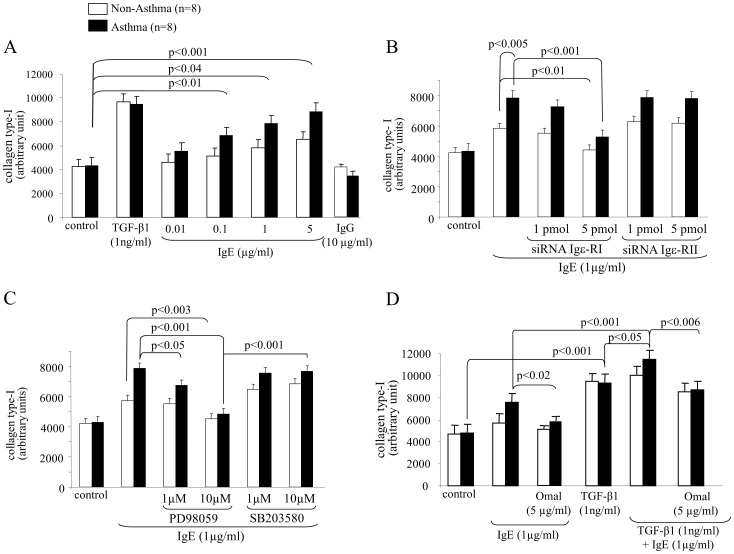
IgE induces collagen type-I deposition by ASMC through Igε-RI and Erk1/2 MAPK.(A) Induction of collagen type-I deposition by IgE by ASMC and (B) the mediator role of Igε-RI and Igε-RII. (C) Contribution of MAPK to Igε-RI and Igε-RII signalling on IgE induced collagen type-I deposition by ASMC. (D) Specificity of IgE neutralising antibody treatment on combined TGF-β1 and IgE collagen type-I deposition by ASMC.